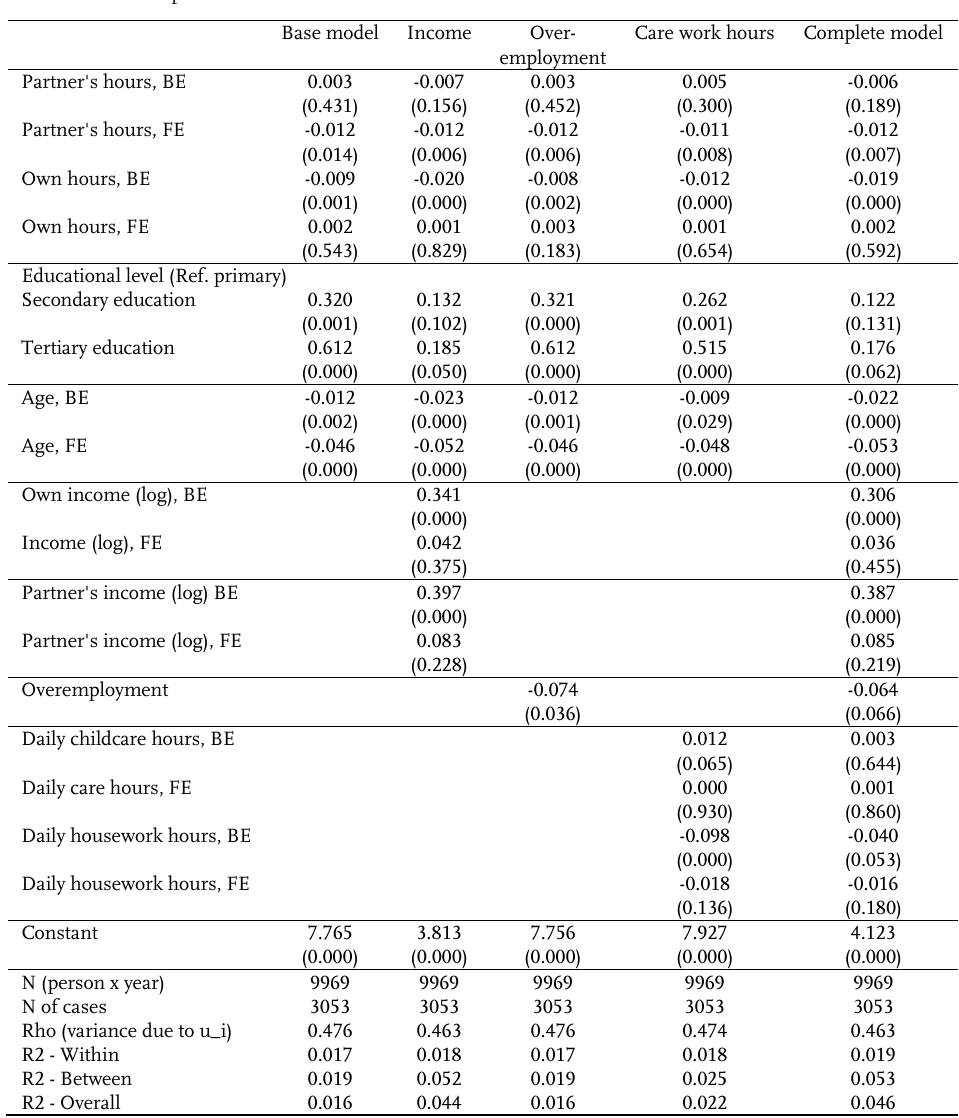
Table A.3 : Estimated coefficients of the hybrid model: Women with children < 14 in the household; p values in parentheses Base model Income Over- Care work employment